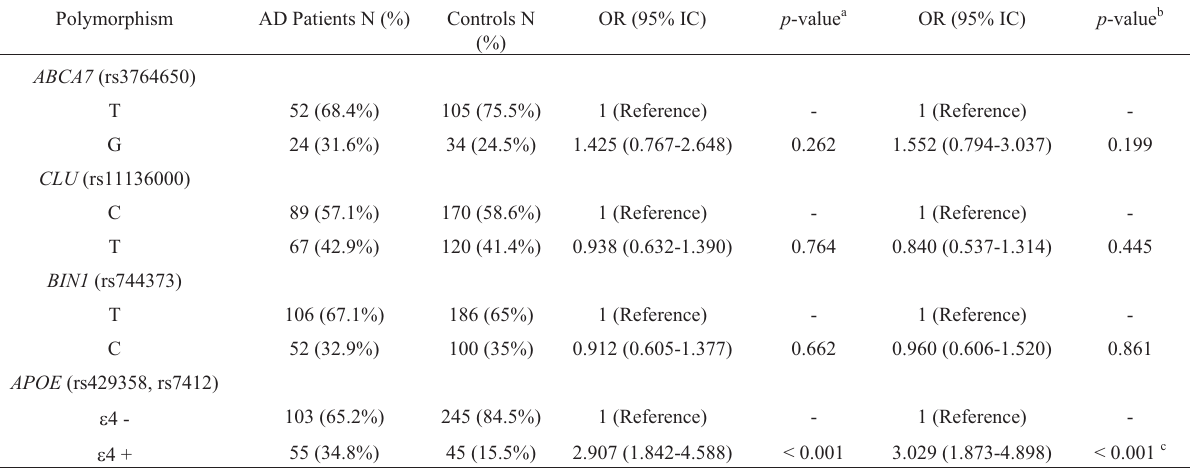
Table 2 - Test for independent interaction of SNPs with